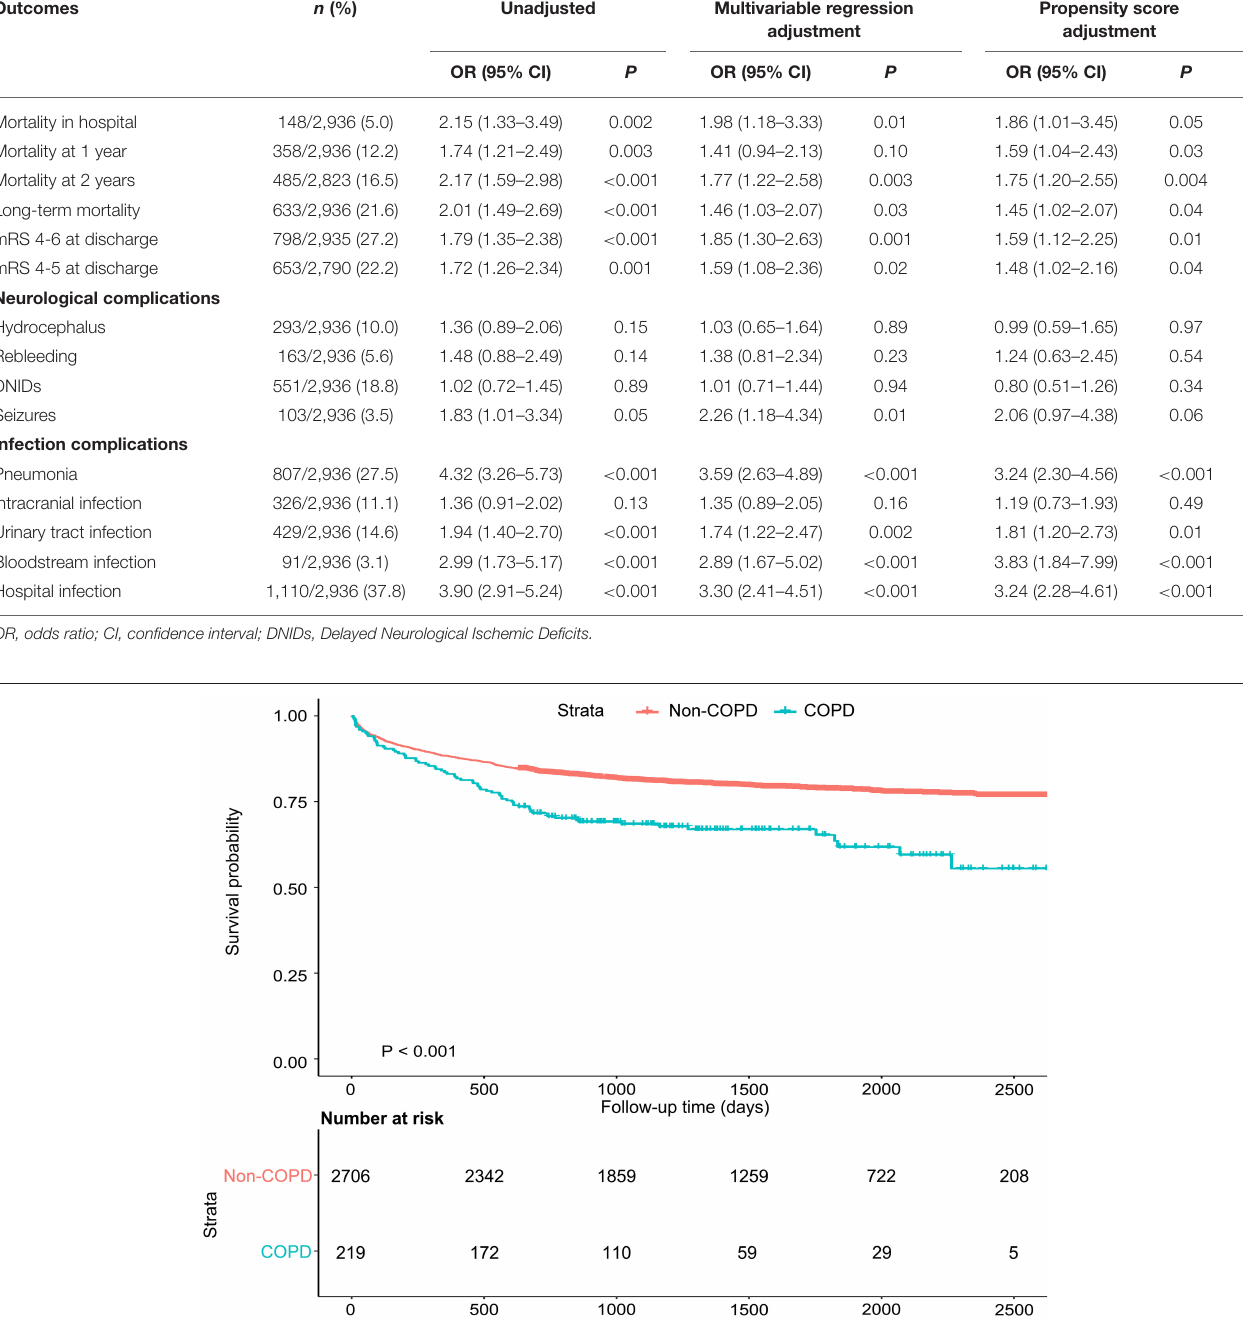
as seizure (22). Fourth, COPD are commonly treated with corticosteroids, and hospitalized patients on corticosteroids have a heightened risk of nosocomial